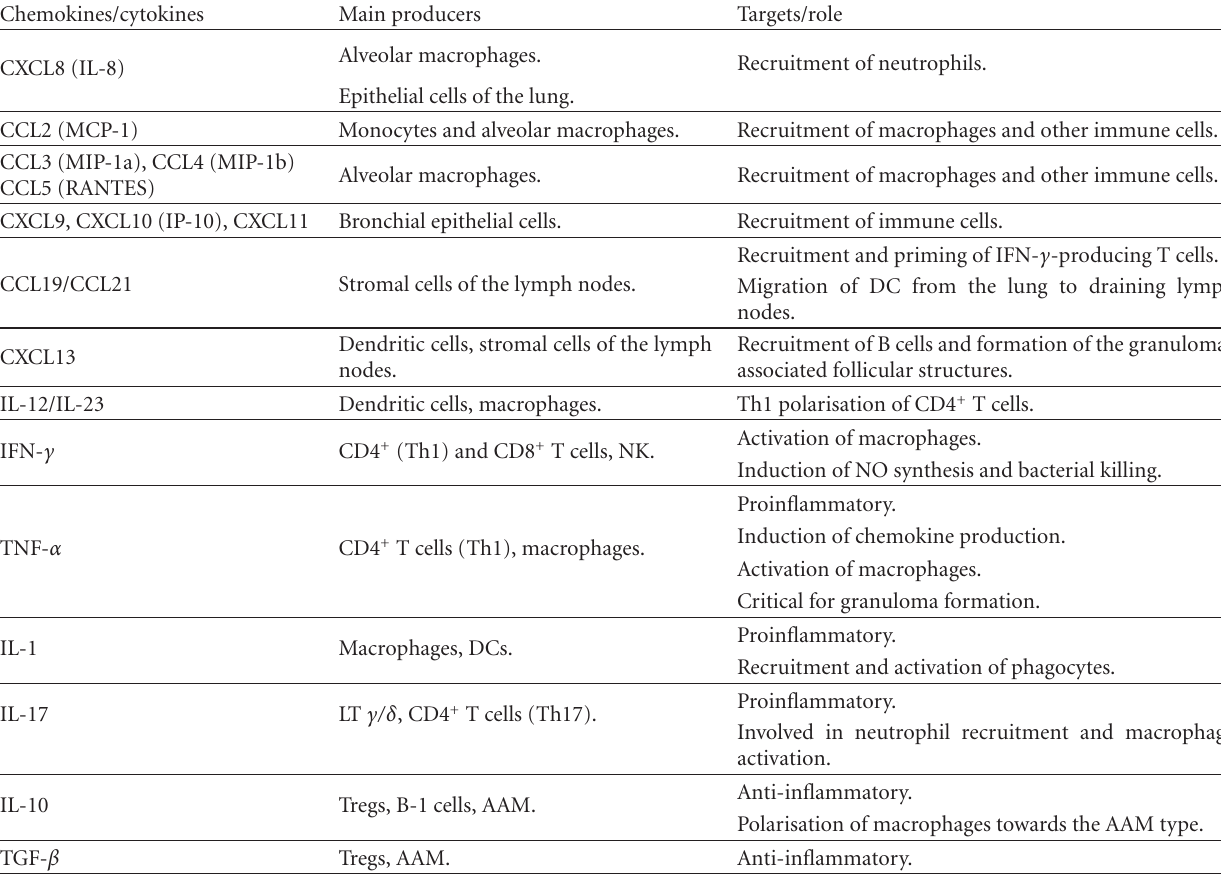
Table 2: Main chemokines and cytokines involved in the granulomatous